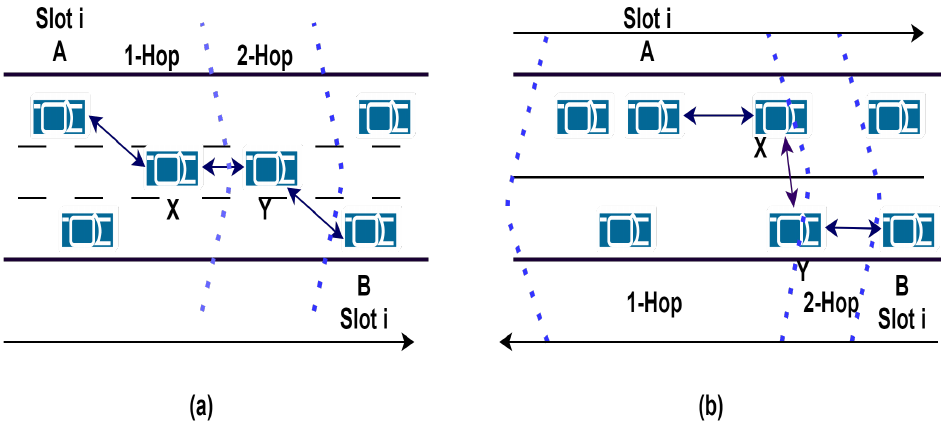
Figure 4. Potential collision detection: ( a ) same direction; ( b ) opposite direction